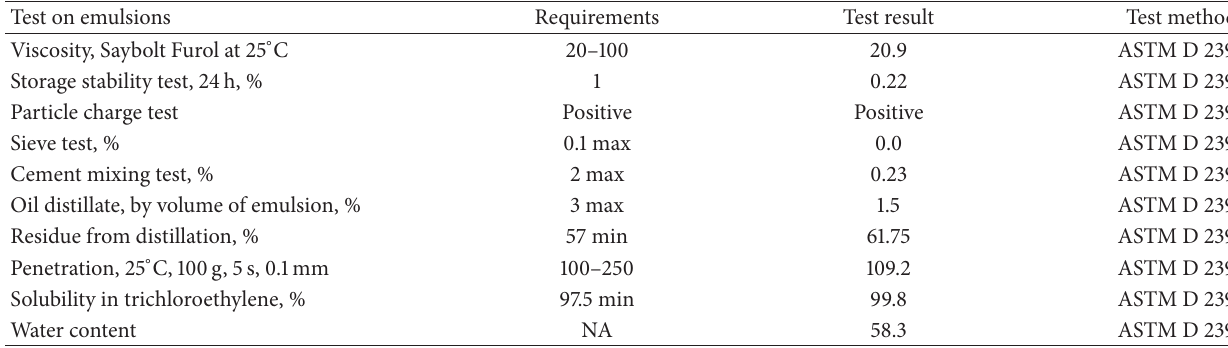
Table 3: Properties of bitumen emulsion.